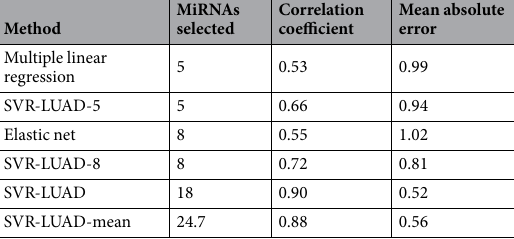
0.48 and 1.083 year, and Ridge regression achieved a correlation coefficient and mean absolute error of 0.51 and 1.086 year, respectively. The Elastic net method with 8 miRNAs achieved a correlation coefficient and mean abso- lute error of 0.55 and 1.02 year, and Multiple linear regression with 5 miRNAs obtained a correlation coefficient and mean absolute error of 0.53 and 0.99 year, respectively. To fairly compare SVR-LUAD with these methods, the feature numbers of SVR-LUAD were restricted to 5 and 8. SVR-LUAD-5 with 5 miRNAs obtained a correlation coefficient and mean absolute error of 0.66 and 0.94 year, respectively. SVR-LUAD-8 with 8 miRNAs obtained a correlation coefficient and mean absolute error of 0.72 and 0.81 year, respectively. The correlation plots of the real and estimated survival time for SVR-LUAD, Elastic net, and Multiple linear regression are shown in Fig. 1. The correlation plots for LASSO and Ridge regression are shown in Supplementary Fig. S2. SVR-LUAD is better than these compared methods.